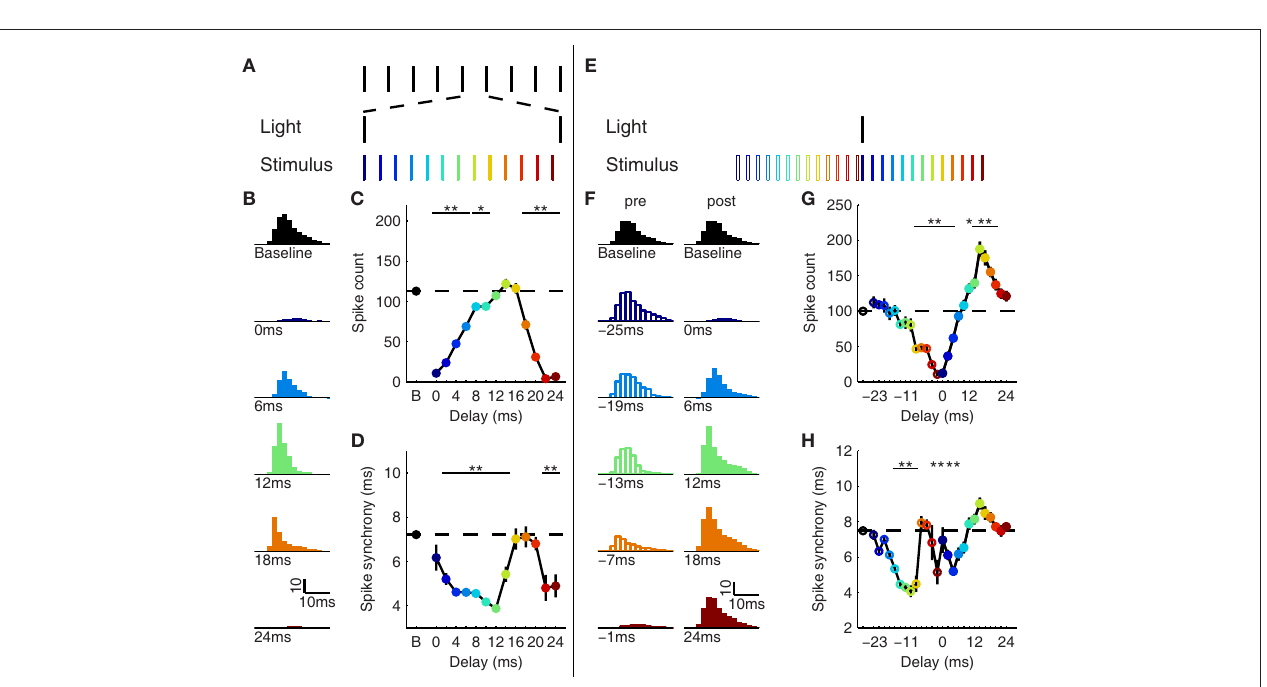
Figure 2 | Timing-dependent impact of inhibition on sensory responses. (A) Stimulation paradigm for repetitive inhibition. A single sensory stimulus was given at different phases in between two light pulses embedded in a light train at 40 Hz. (B) Population X1 response at baseline (top) and different phases during repetitive inhibition. (C) Spike count for each phase of stimulation. Dashed line indicates baseline condition. (D) Spike synchrony, defined as inter-quartile range of spike times across the population (smaller numbers